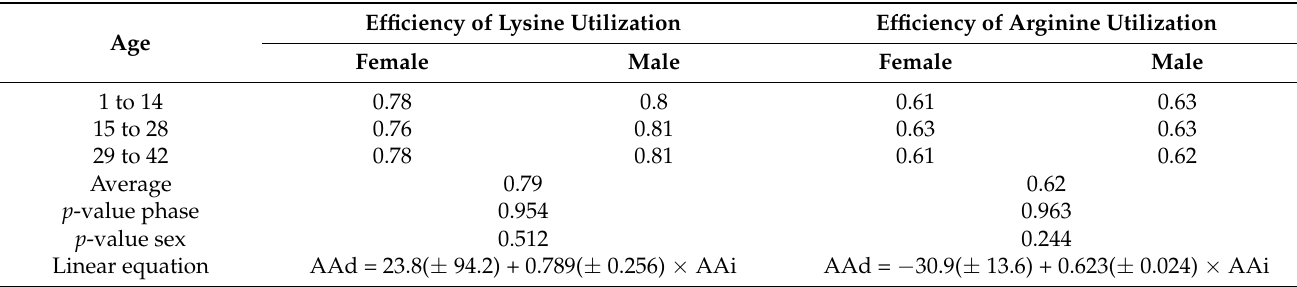
Table 7. Efficiency of lysine and arginine utilization for male and female broiler chickens, and the equation of amino acid deposition (AAd) in the function of intake (AAi) adjusted to estimate the efficiency of utilization.